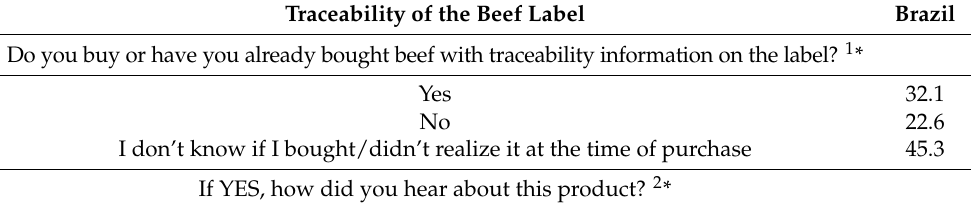
Table 5. Opinion of Brazilian consumers on information related to the traceability in beef labels. Traceability of the Beef Label